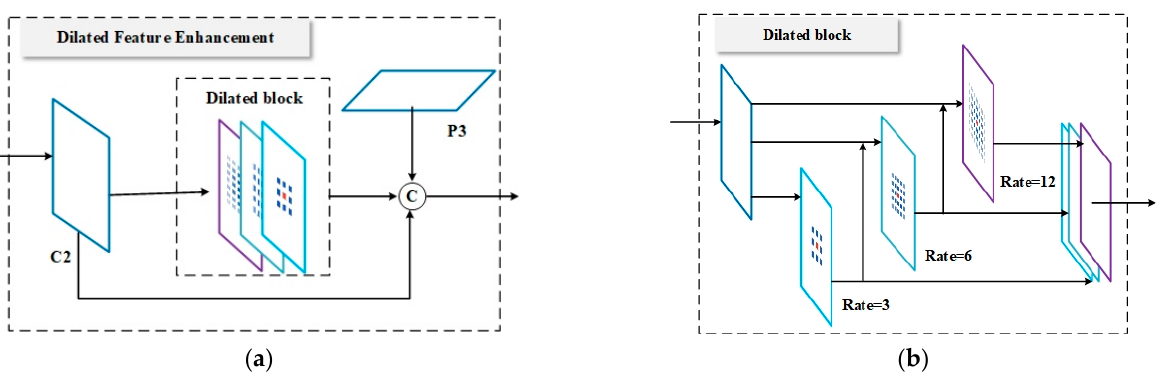
Figure 4. Illustration of Dilated Feature Enhancement (DFE): ( a ) the abbreviated structure of DFE; ( b ) the structure of Dilated block.